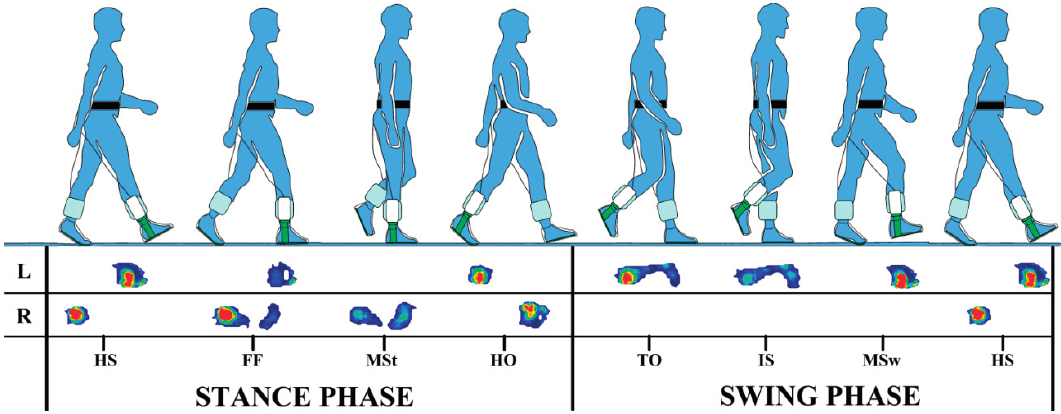
Figure 1. An example of in-shoe plantar pressure measurement during the major phases and events of a full gait cycle (right heel strike to right heel strike). HS = heel strike, FF = foot flat, MSt = midstance, HO = heel off, TO = toe off, IS = initial swing, MSw =